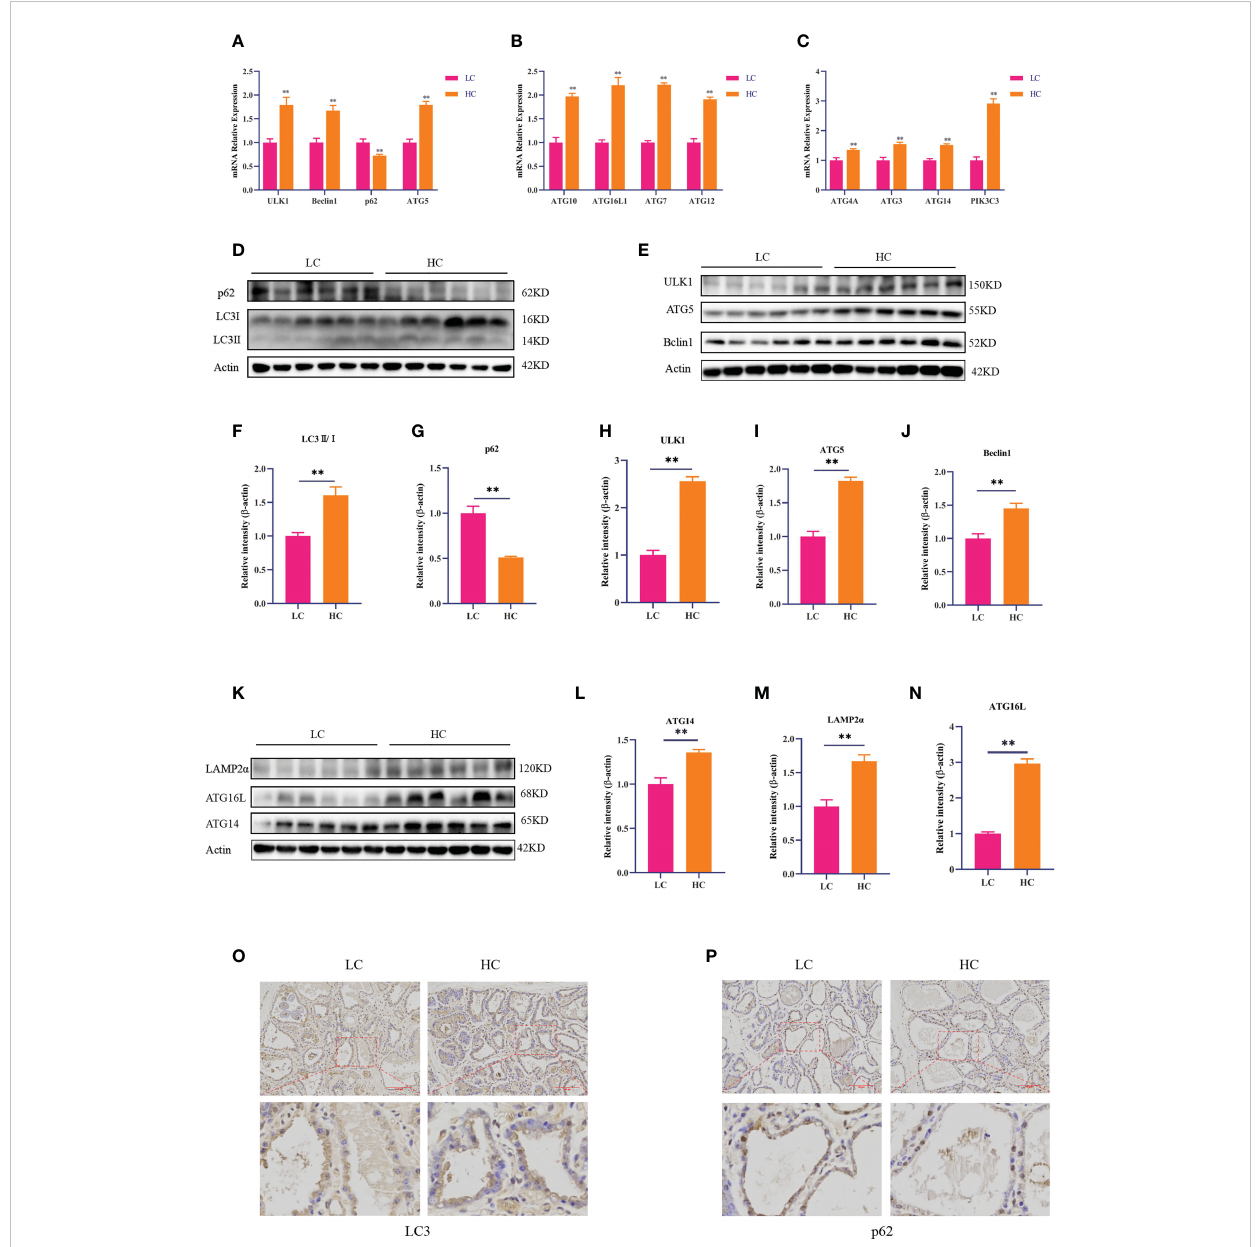
FIGURE 2 Expression of autophagy-related genes and proteins in mammary gland tissue of dairy cows fed low-concentrate (LC) and high-concentrate (HC) diets. mRNA expression of autophagy-related genes (A – C) . Protein expression levels of LC3, p62, ULK1, Beclin1, ATG5, ATG14, ATG16L, and LAMP2 a (D, E, K) . Protein abundance was normalized to the respective abundance of b -actin (F – J, L – N) . Sections of mammary gland tissue from dairy cows in the LC diet and HC diet groups, immunostained for LC3 and p62 (200× magni fi cation, (O, P) . Red bar, 200 m m. Results are presented as the mean ± SEM. ** p <